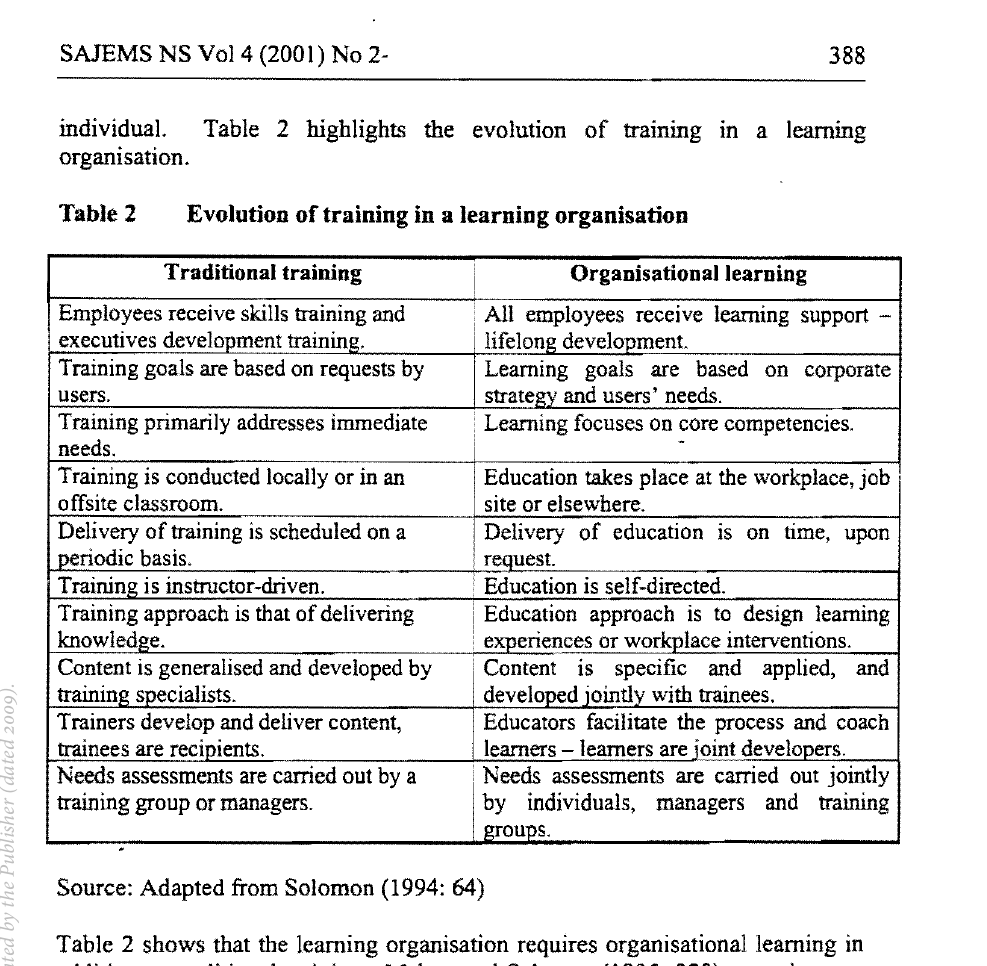
Table 2 highlights the evolution of training in a learning organisation. Table 2 Evolution of training in a learning